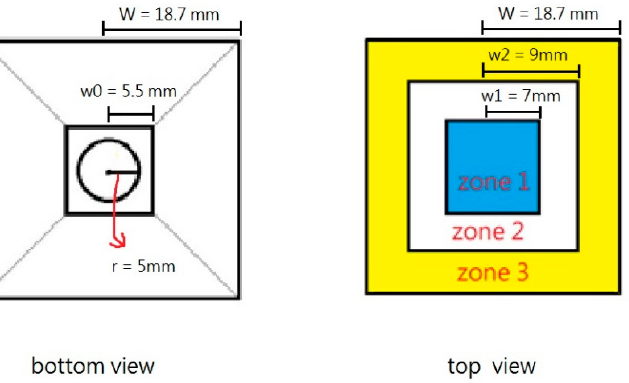
Figure 6. The bottom view and the top view of our final design. The lighting guide is cuboid in shape.